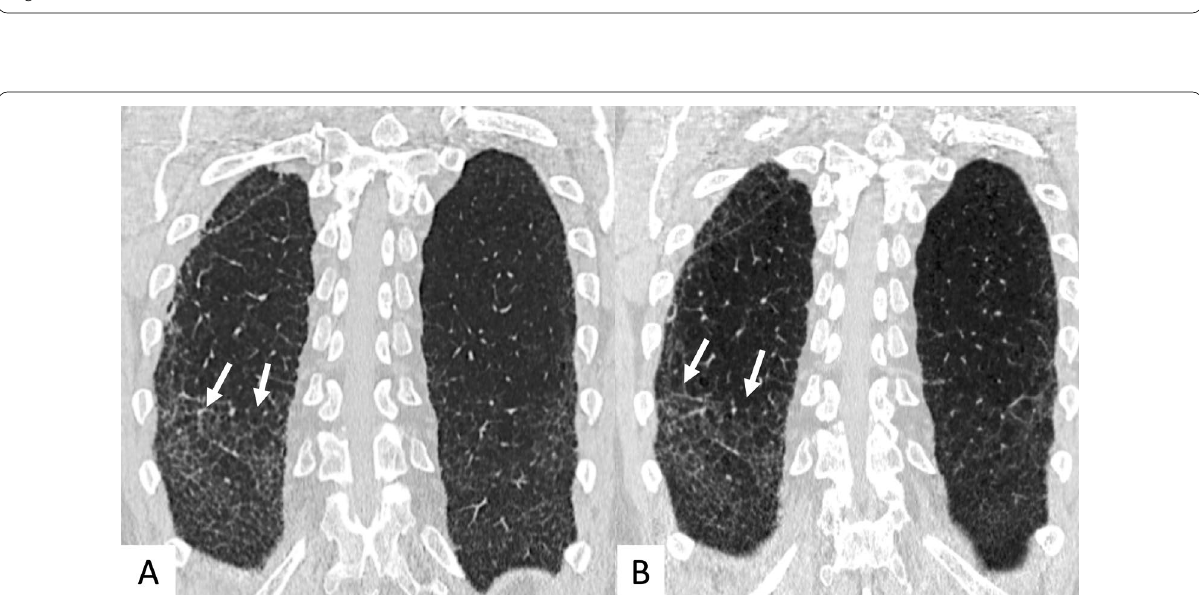
Fig. 6 Coronal multiplanar reformatted images. A , B demonstrate the presence of straight-edge sign in female RA patients showing interstitial lung fibrosis. This sign consists of a more pronounced fibrosis in the lung bases—with sharp demarcation in the cranio-caudal plane (white arrows in A , B